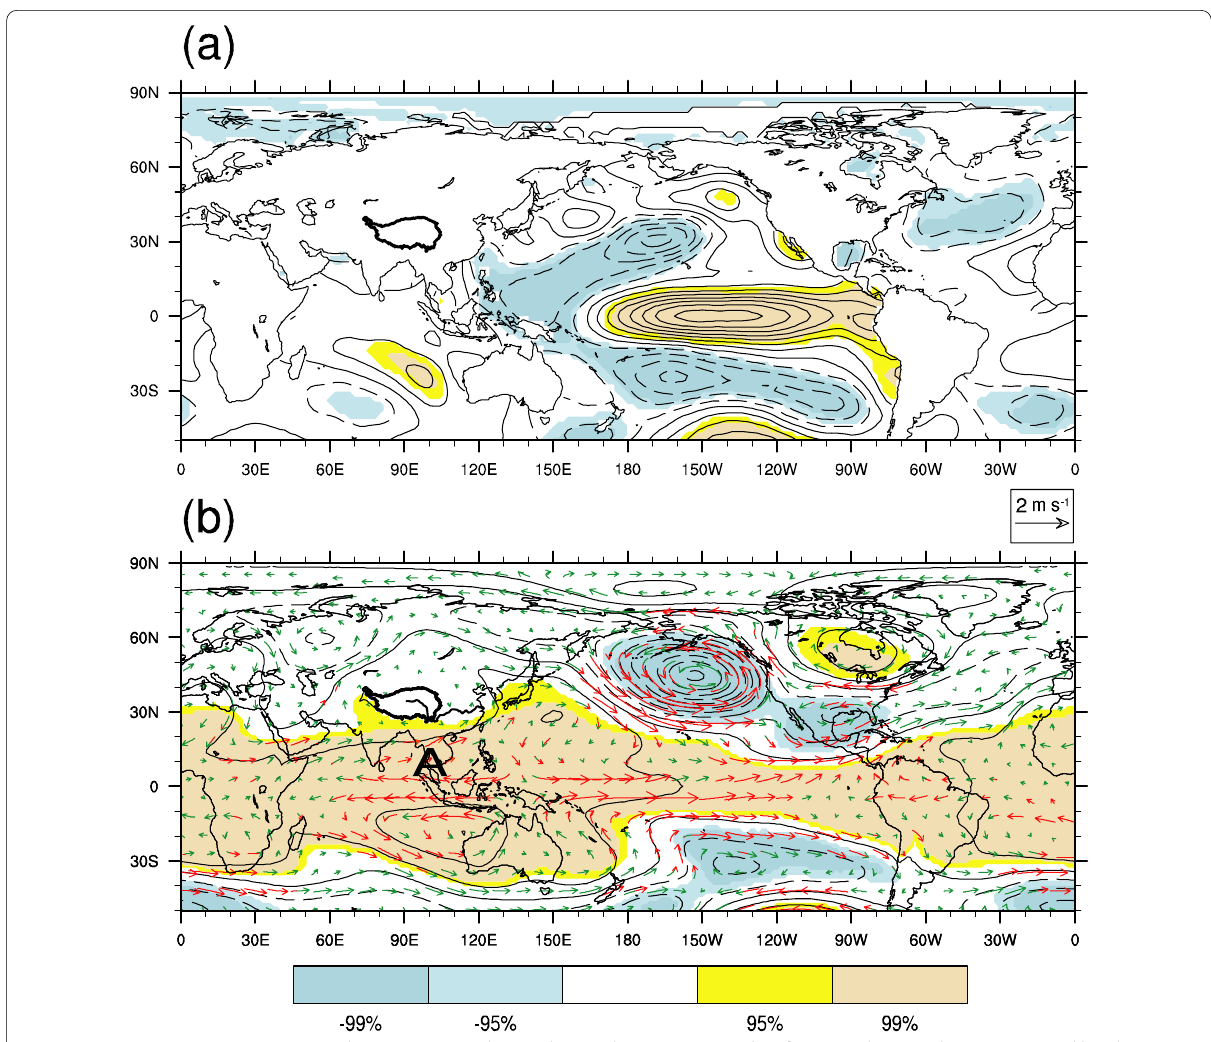
Fig. 9 (a) Winter SSTAs (contours interval: 0.1 °C) regressed upon the simultaneous WIBT index. ( b) Anomalous 700‑hPa geopotential height (contours interval: 40, m 2 s − 2 ) and winds (units: m s − 1 ) regressed upon the Niño 3.4 index in winter for the period 1979–2019. Shadings denote positive/negative SSTA anomalies and geopotential height significant at the 95% and 99% confidence levels as shown by the color bars. Anomalous winds significant at the 99% confidence level are highlighted in red. “A” in (b) denotes the anomalous anticyclone response to the ENSO‑related forcing. The thick black contour denotes the Tibetan